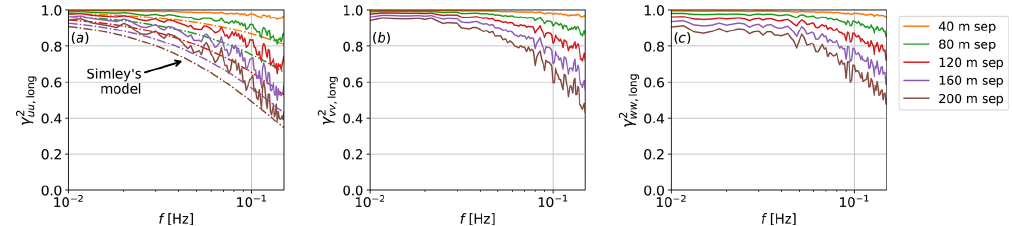
Figure 9. Coherence of the three turbulence components (a) u , (b) v , and (c) w separated longitudinally. Also shown is Simley’s model (Eq. 5). Note the logarithmic scale of the x axis.